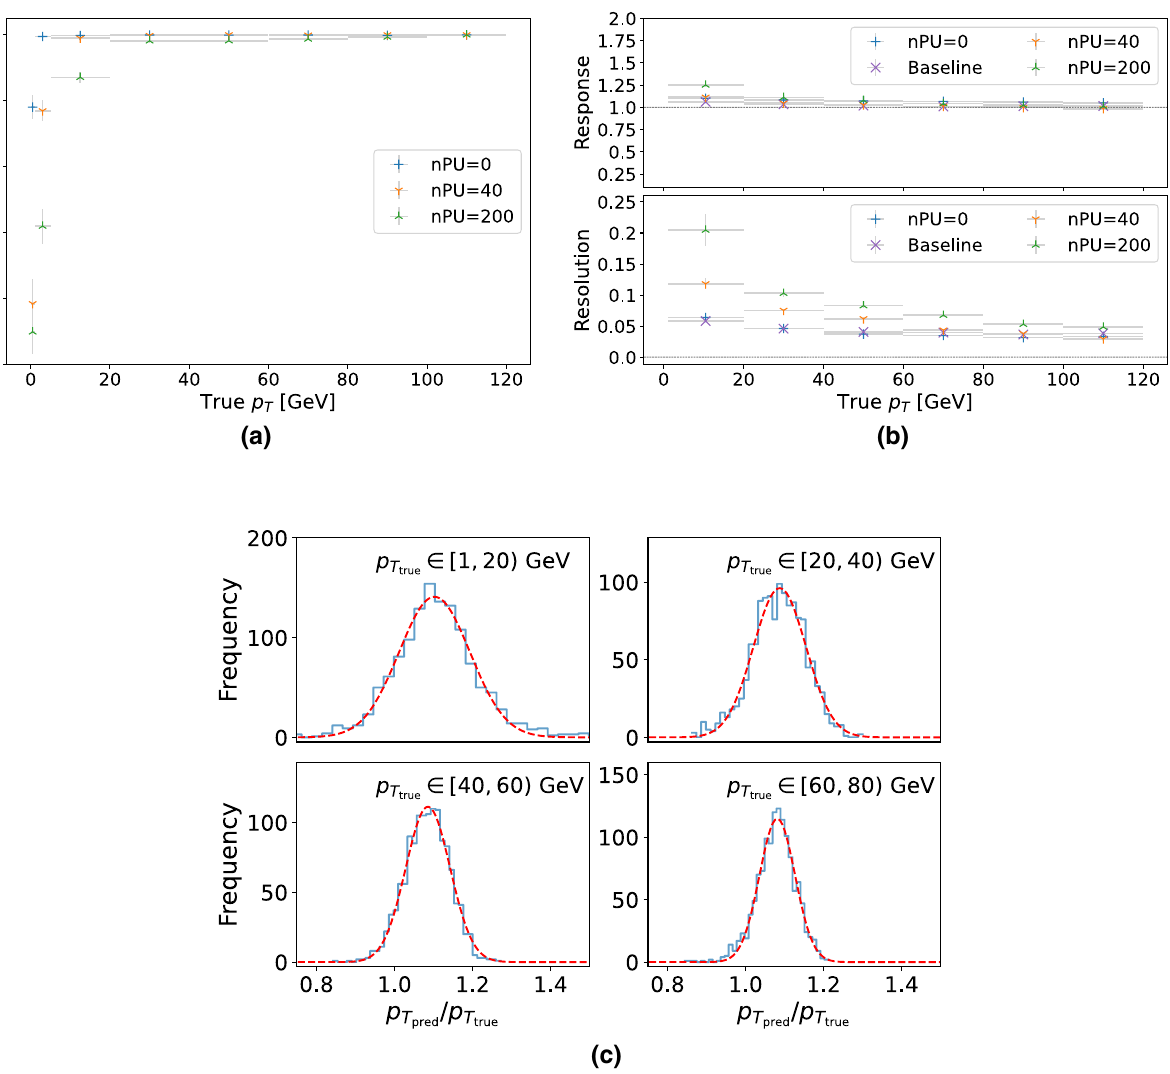
Fig. 10 Reconstruction performance of electromagnetic particles (photons and electrons) in different pileup environments. a Efficiency as a function of the true p T . b Mean response (top) and resolution (bottom) as a function of the true p T . The response and resolution are